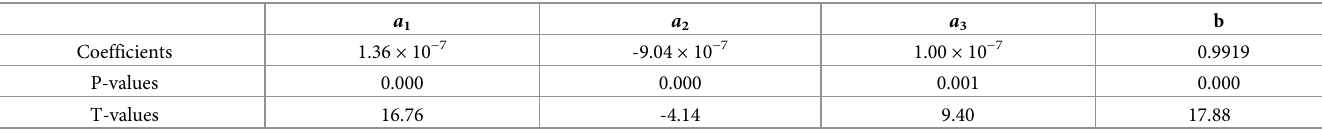
Table 6. Regression coefficients, p-values, and